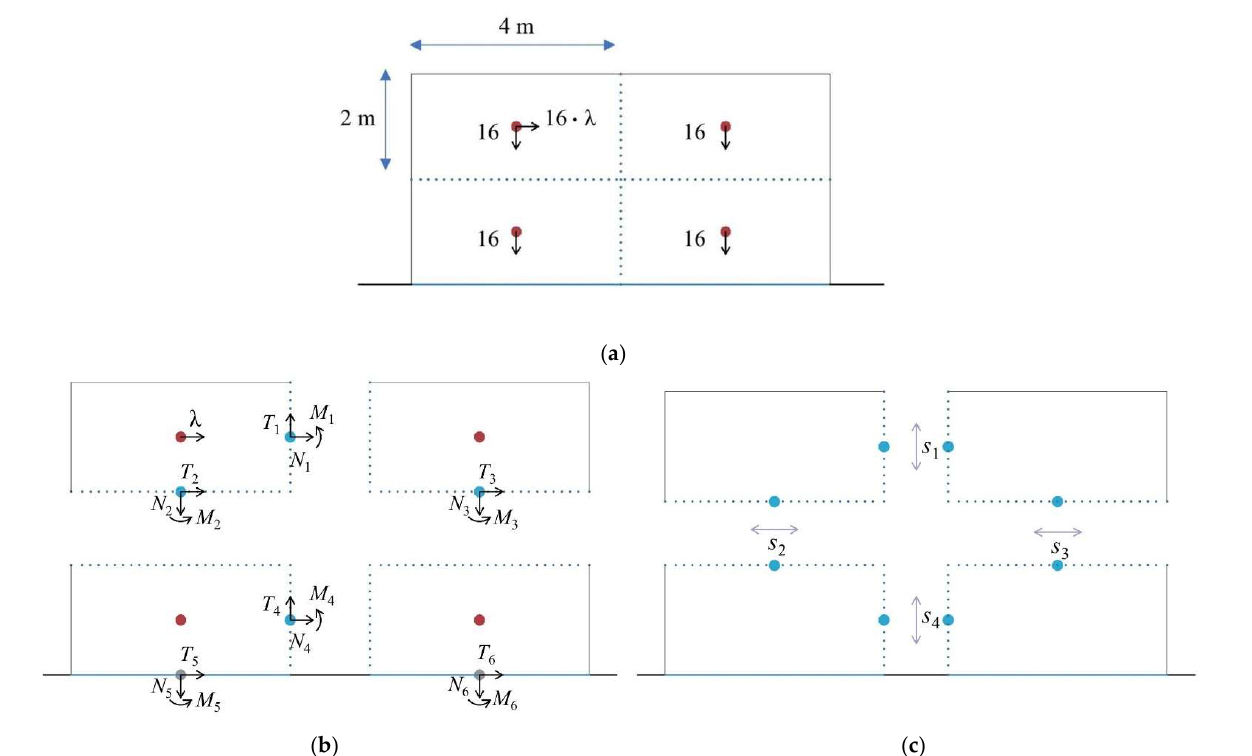
Figure 5. ( a ) Same 2D problem as Figure 4a developed using classic limit analysis. Variables involved in the segmentation method, including: ( b ) the load factor and the internal forces and moments; ( c ) the shear strength at each interface.